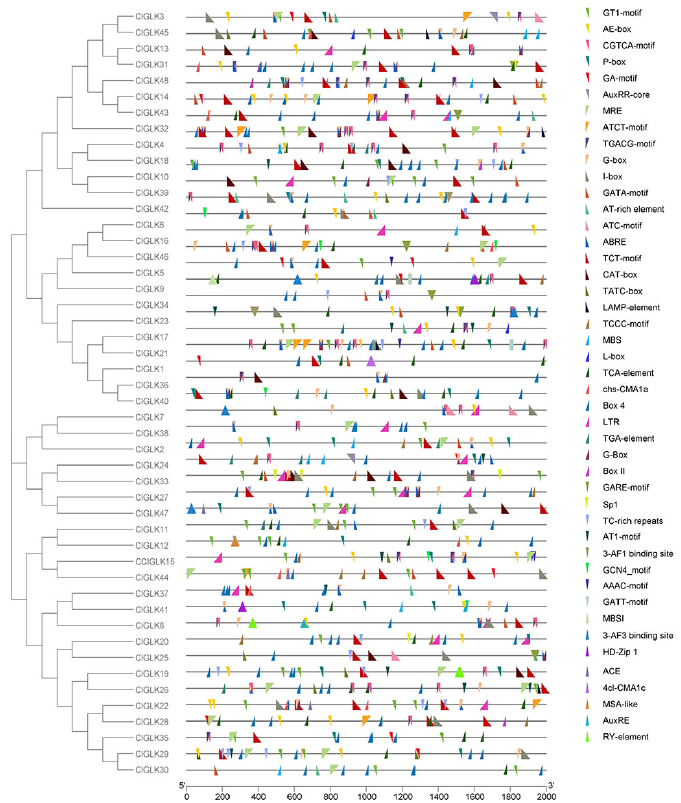
Figure 3 . Cis ‐ elements analysis of the promoters of ClGLKs. The classification and annotation of the cis ‐ elements are listed in Table S3.